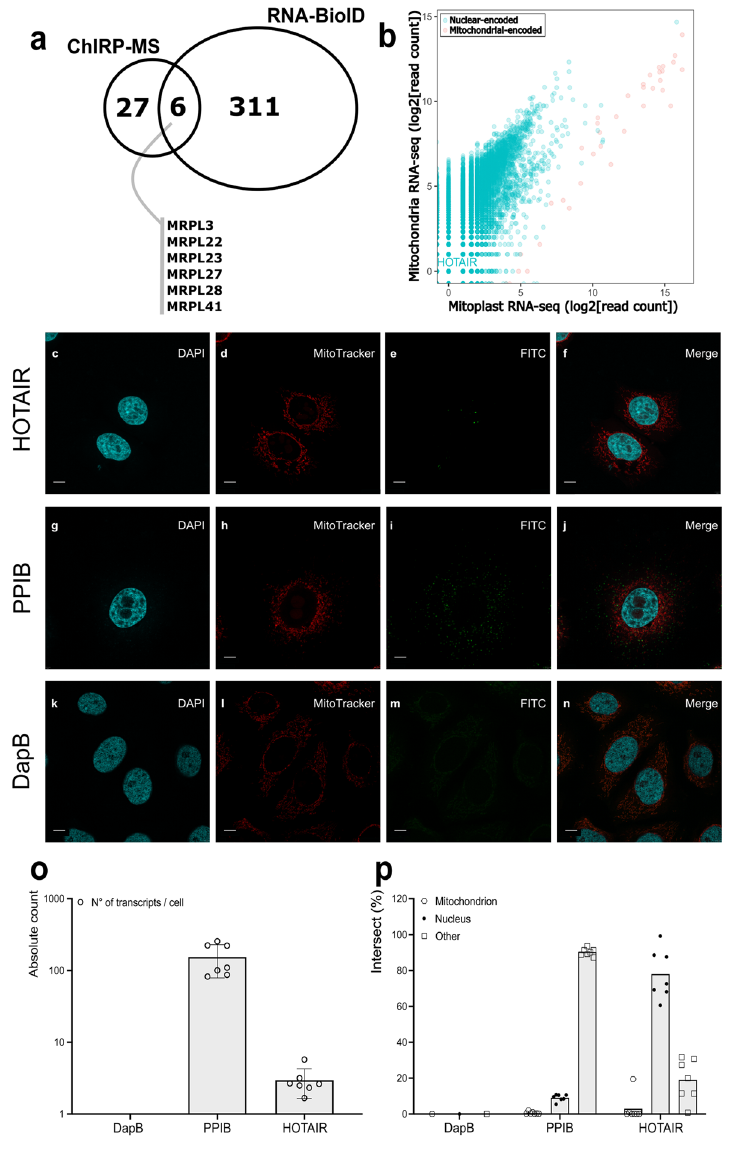
data of Mercer et al. Nuclear-encoded genes are shown in green. Mitochondrial-encoded genes are shown in red. HOTAIR is highlighted. Colocalization of HOTAIR ( C – F ), PPIB mRNA positive control ( G – J ), and DapB mRNA negative control ( K – N ) with mitochondria in MCF7 determined by staining with RNAscope (FITC) and MitoTracker. ( O ) Determined transcript abundances per cell (n = 7) for each of the targets based on RNAscope puncti. ( P ) Intersect analysis (n = 7) showing percentage of the total transcript pool with mitochondria (hexagons) or nuclei (circles). Transcripts present in unstained organelle are shown as other (squares). The scale bar depicts 7.5